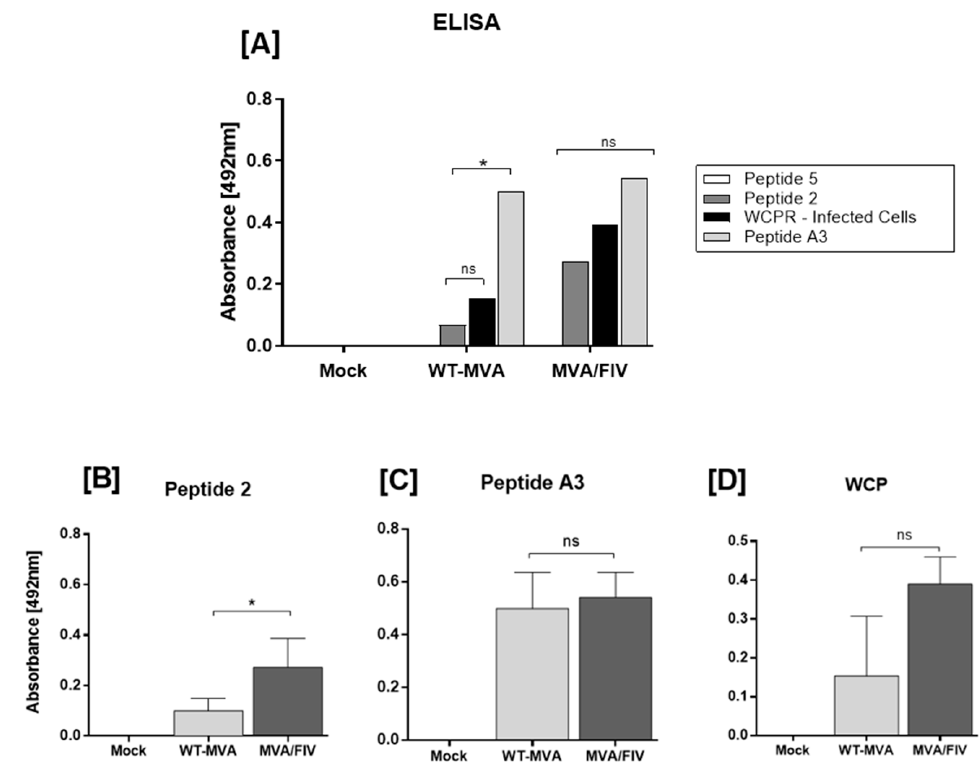
Figure 3. Peptide ELISA. ( A ) Overview of the serum reaction of the mock, WT-MVA and MVA/FIV-B groups to the presented substrates, peptide 2, peptide 5, WCP and peptide A3. ( B ) Response to peptide 2 where a significant difference is observed between WT-MVA and MVA/FIV-B, while Mock remained nonreactive. ( C ) Response to control, peptide A3. It is observed that animals immunized with viruses (WT-MVA or MVA/FIV-B) reacted in a very similar way, while the mock remained nonreactive. ( D ) Response to the WCP substrate composed of protein extract from BHK-21 cells infected with MVA/FIV-B. It is observed that the WT-MVA group showed a low reactivity compared with the MVA/FIV-B group, although this difference is not statistically specific. Mock group remained nonreactive. * p <